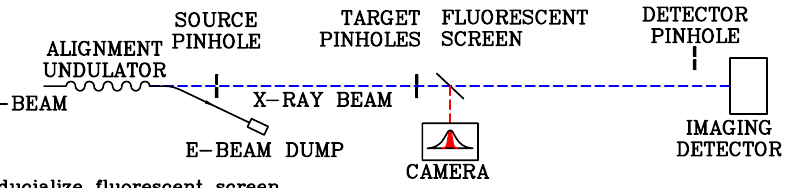
FIG. 6. (Color) Fiducialization of a fluorescent screen near a target pinhole by taking the x-ray beam image on the fluorescent screen after aligning the x-ray